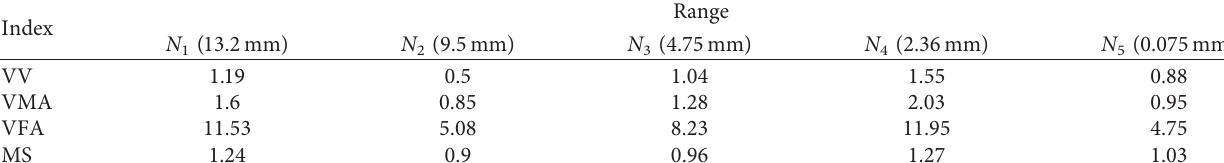
Table 10: Range analysis of orthogonal tests.